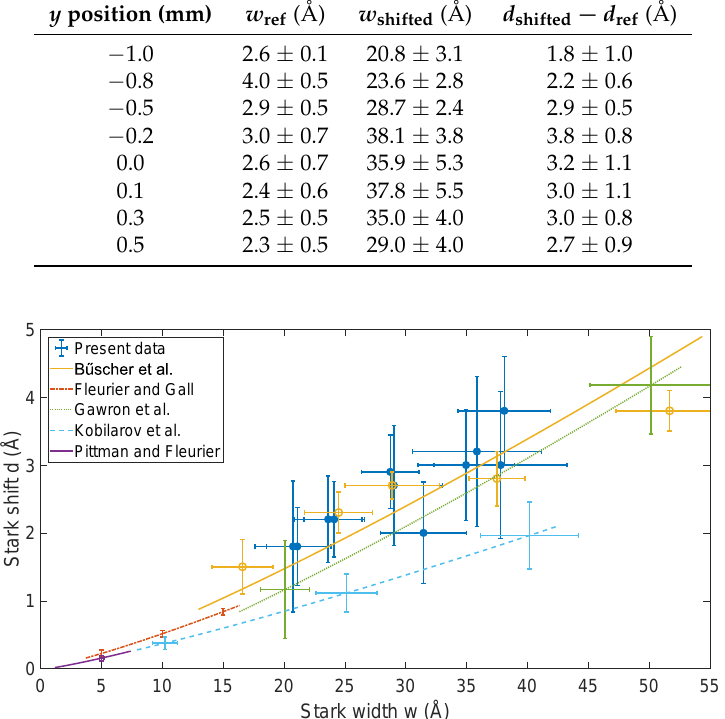
Figure 4. Experimentally obtained width and shift. The results from the present study are compared to different data from the literature. Table 2. Details on experimental setups from the